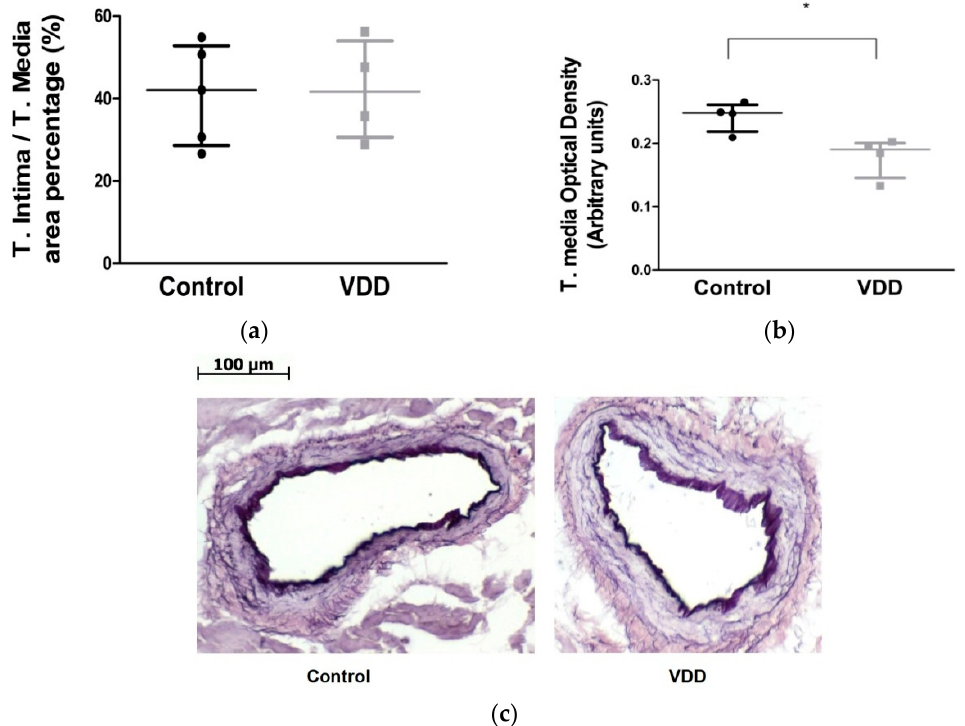
Figure 5. Histological properties of coronary arterioles. ( a ) T. Intima/T. Media area percentage (%, n = 5–4); ( b ) T. Media optical density ( n = 4–4) of resorcin–fuchsin-stained coronary arterioles. Mann–Whitney U-tests. Median [IQR], *: p < 0.05; ( c ) representative photos of resorcin–fuchsin-stained male rat coronary arteriole segments from control and vitamin-D-deficient groups. Scale bar, 100 μ